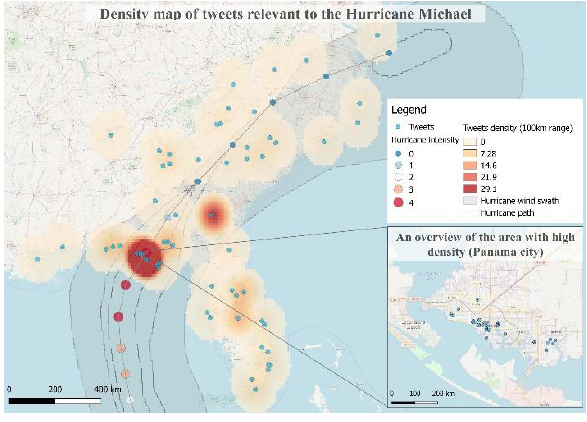
Figure 4. Kernel density map